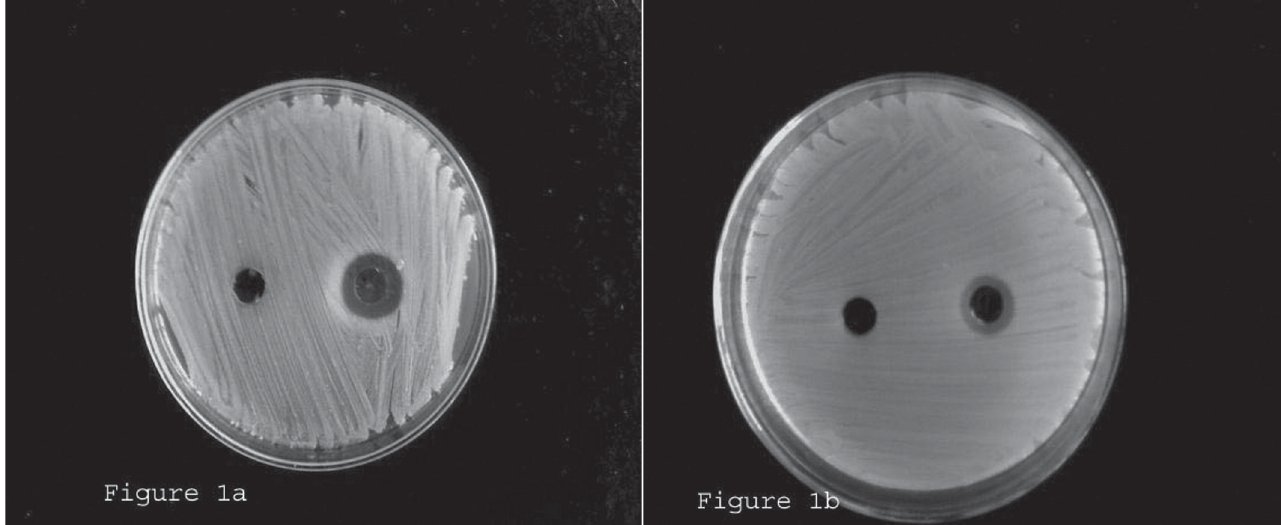
Fig. 1. Zone of antifungal inhibition against C. albicans shown by acetonic extract of P. cubeba (a) and ethanolic extract of P. longum (b), determined by agar well diffusion method and the control. activity against S. aureus, the highest inhibition zone being 18.96 mm followed by the methanolic (17.65 mm) and ethanolic (17.32 mm) extracts (Table 1). S. aureus survived up to 12.5 mg/mL, thus having a MIC of 25 mg/mL (Table 2,